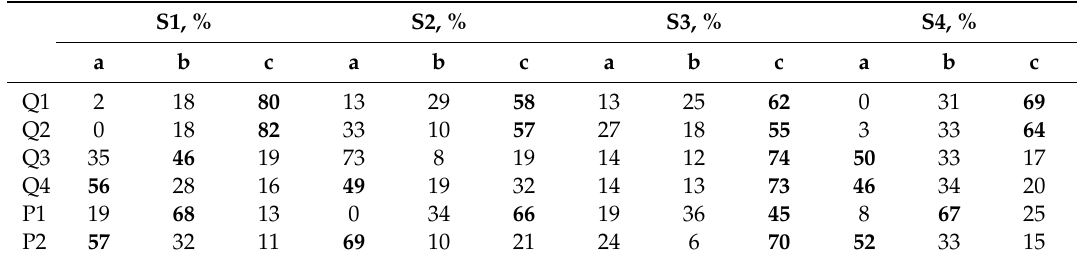
Table 3. Cross-table with survey results for questions S1, S2, S3, and S4 as percentages. S1, % S2, % S3, % S4,